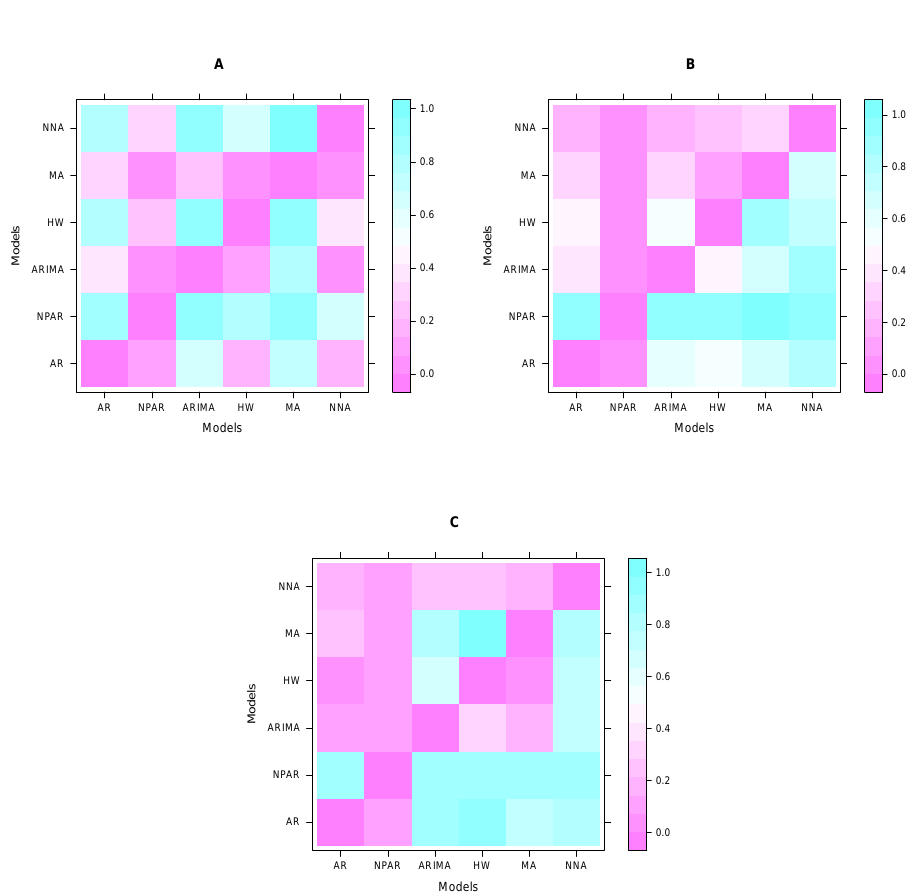
Figure 5. Results ( p -value) of the DM test for confirmed cases ( A ), death counts ( B ), and recovered cases ( C